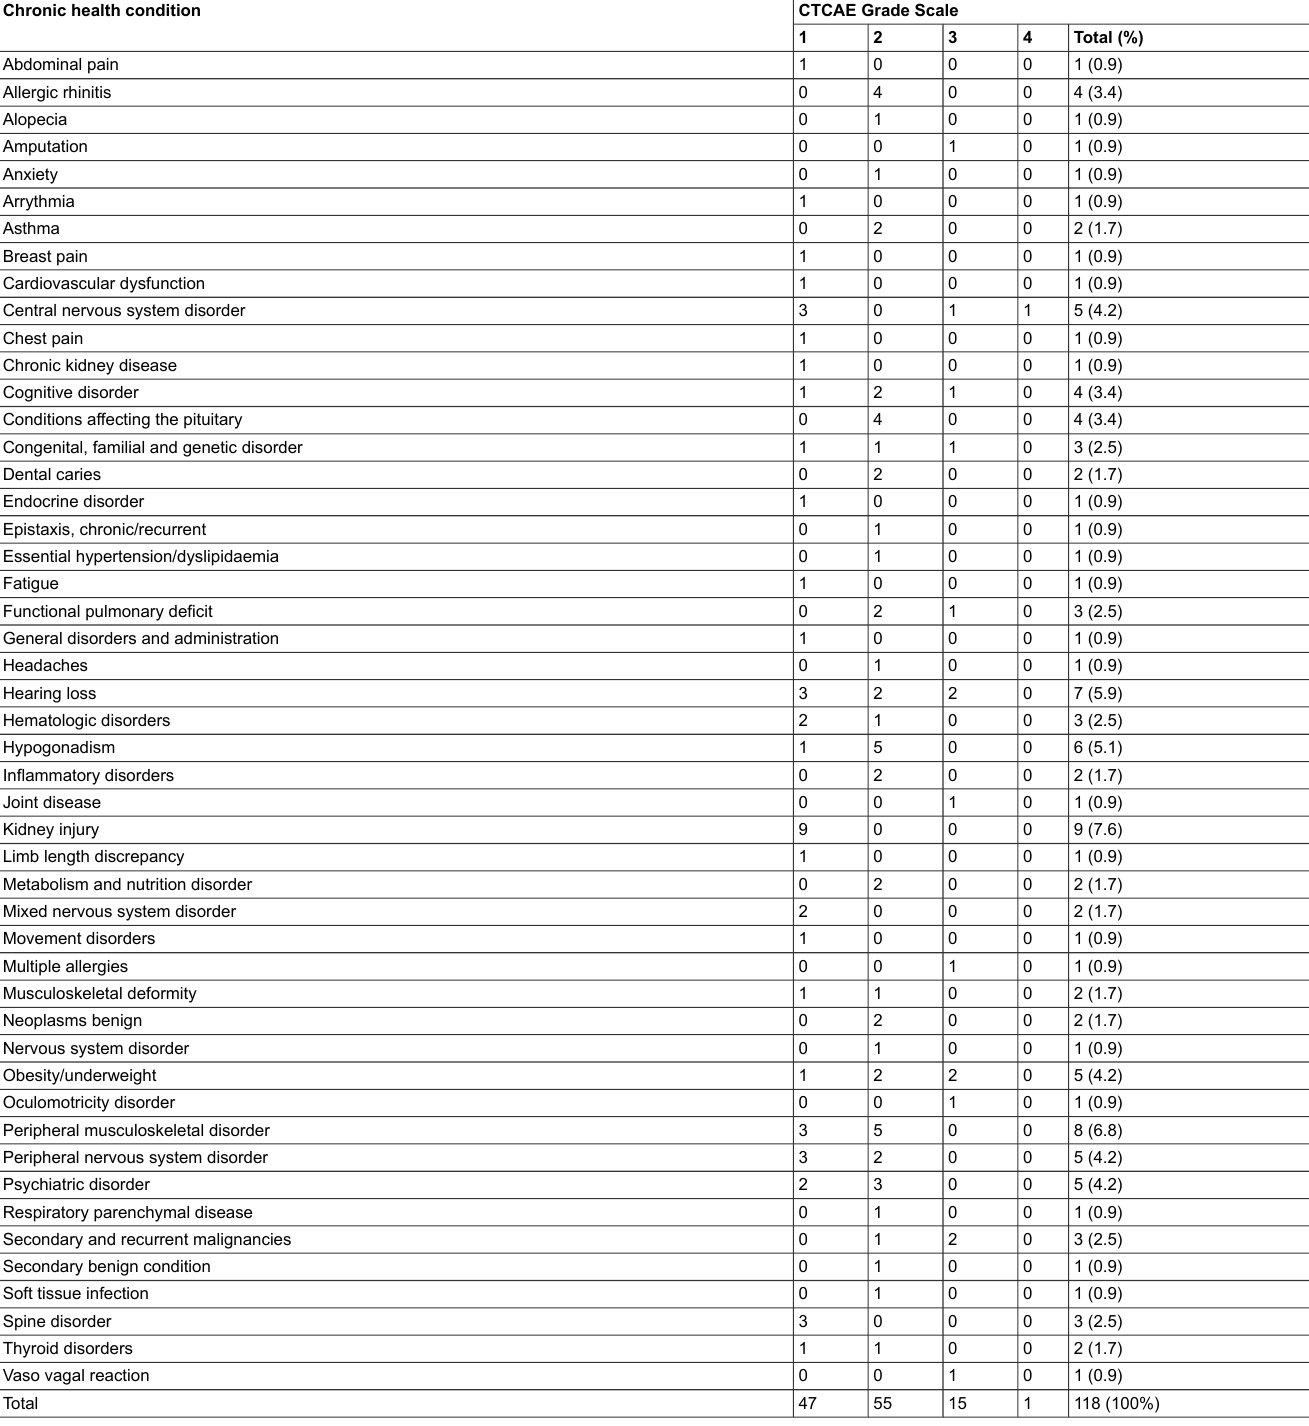
Table S4: Number of each type of chronic health condition specific condition according to the CTCAE grade